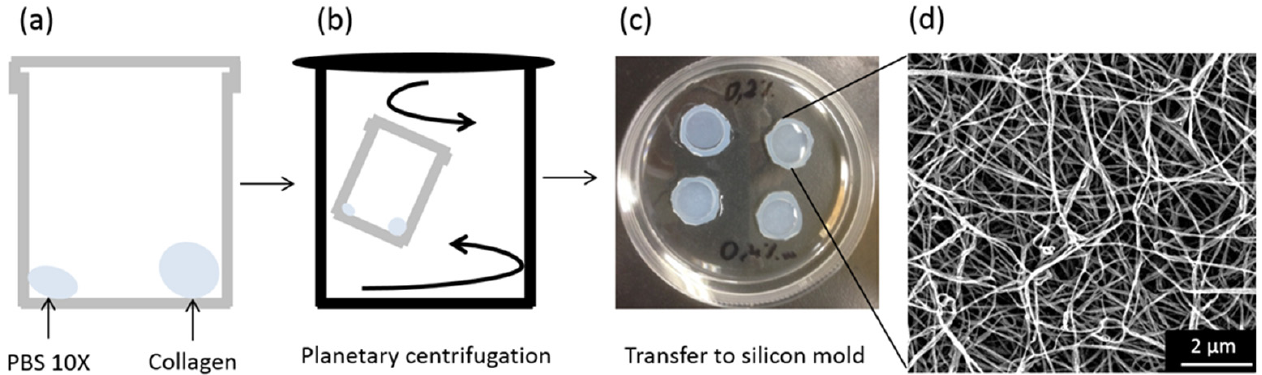
Figure 1. Collagen gel preparation (no magnetic alignment). ( a ) Collagen and PBS are introduced into a plastic pot (9:1, v : v ). ( b ) A double rotation system allows removing air bubbles. ( c ) After transfer into a 2 mm thick silicone mold, gelling solutions are left at 28 °C for 3 h. ( d ) SEM images of collagen fibrillary networks.